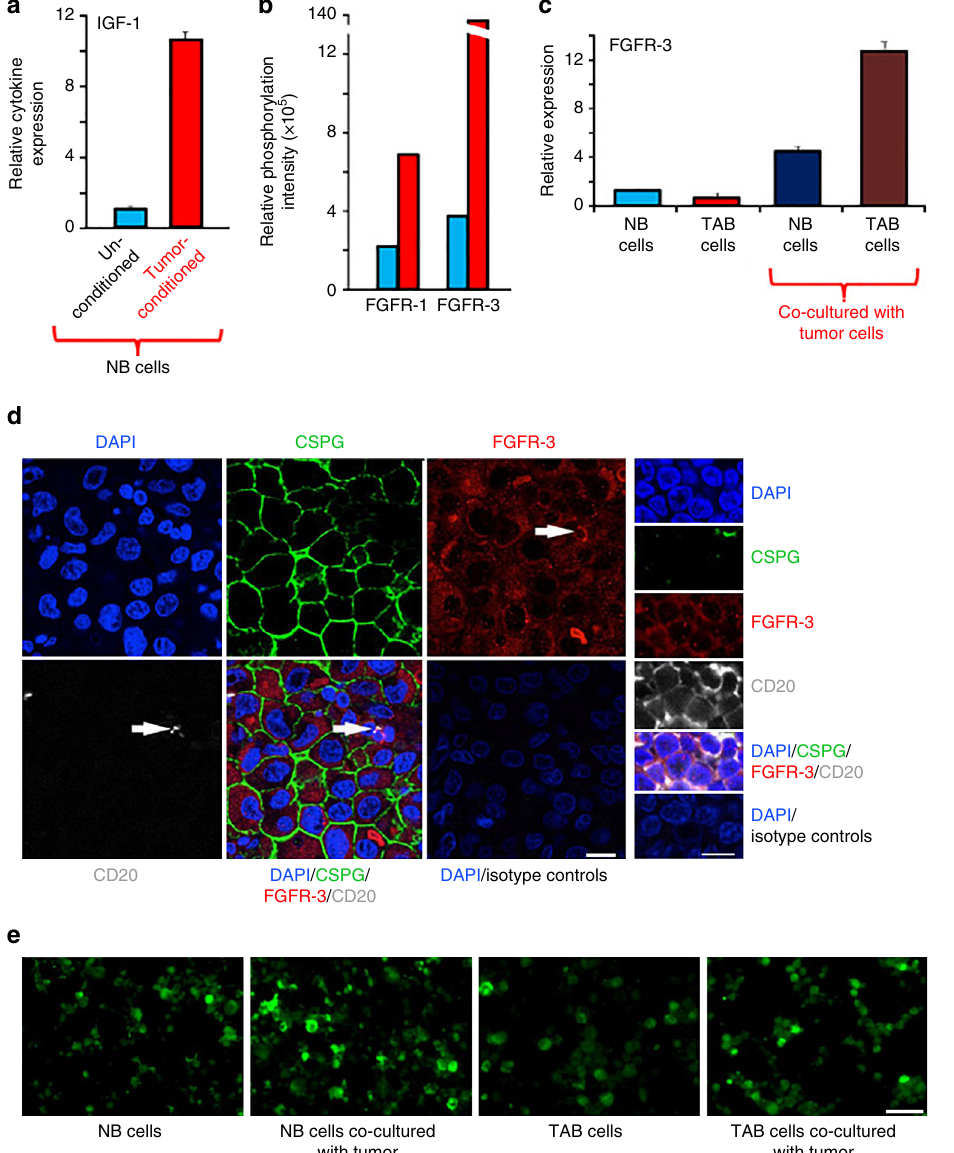
Fig. 2 Melanomas convert normal B cells to a tumor-associated phenotype with high growth factor production for tumor stroma-tumor cell cross-talk. a NB cells from healthy volunteer (NB cells) co-cultured with melanoma tumor lineWM3749 (tumor-conditioned; red bars ) show increased expression of growth factors and in fl ammatory cytokines, including IGF-1 (see Supplementary Fig. 4 for fresh NB cells), IL-1 α / β and PDGF-A/-B (Supplementary Fig. 3b) when compared with unconditioned NB cells from the same healthy volunteer ( blue bars ). The B cells were harvested after 14 days (viability > 90%) and were analyzed by qPCR as in Fig. 1d. Results are representative of 2 independent experiments. b – e Upregulated protein or mRNA expression and phospho- signaling of FGFR-3 in B cells and melanoma cells as determined by qPCR or immunostaining. b NB cells co-cultured with melanoma cells for 48 h ( red bars ) show increased phosphorylation of FGFR-1 and FGFR-3 when compared with unconditioned B cells ( blue bars ) as determined by phospho-RTK array analysis. c NB- ( dark blue bar ) and TAB cells ( dark brown bar ) co-cultured with melanoma cells (WM3749) for 48 h show increased FGFR-3 expression compared with unconditioned normal ( blue bar ) or TAB cells ( red bar ); qPCR as in Fig. 1d. Results are representative of two independent experiments. d Detection of FGFR-3 expression in TAB cells in additional 10 metastatic melanoma patients ’ biopsies by laser scanning microscopy. The 6 larger images on the left show FGFR3 expression in a CD20 + ( grayish white ) CSPG -ve ( green ) B-cell (white arrow) as well as in melanoma cells (CSPG + ; green ). The right panel is a close up into a CD20+ ( grayish white ) lymphocyte cluster of the tumor stroma in direct apposition to melanoma cells (part of a melanoma cell can be seen in the upper right corner by staining for CSPG; green ). Nuclei were counterstained with DAPI ( blue ). Isotype-matched antibodies were used as a control. Representative images are shown. Scale bars : left 25 μ m, right 10 μ m. e Detection of FGFR-3 expression in NB or TAB cells after co-culture (48 h) with melanoma cells (WM3749) detected by immunostaining. Cytospin preparation of normal B or TAB cells after co-culture with melanoma cells show upregulation of FGFR-3 as determined by staining of B cells with rabbit anti-FGR-3 antibody followed by Alexa-Fluor 488 conjugated anti-rabbit antibody. Scale bars : 40 μ m. Images were captured using Nikon fl uorescent